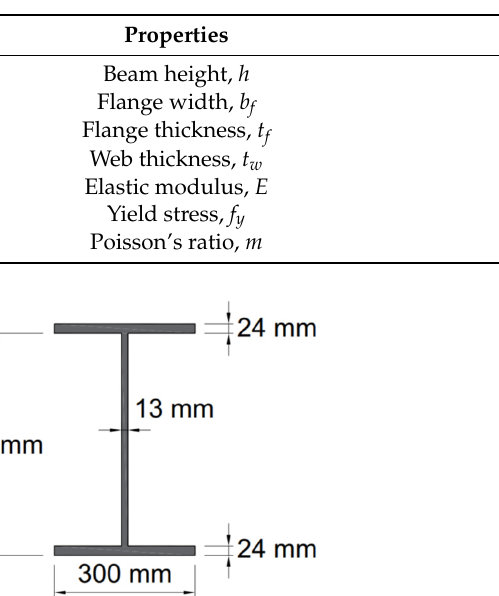
Table 1. Properties of H700x300 (unit: mm, MPa).